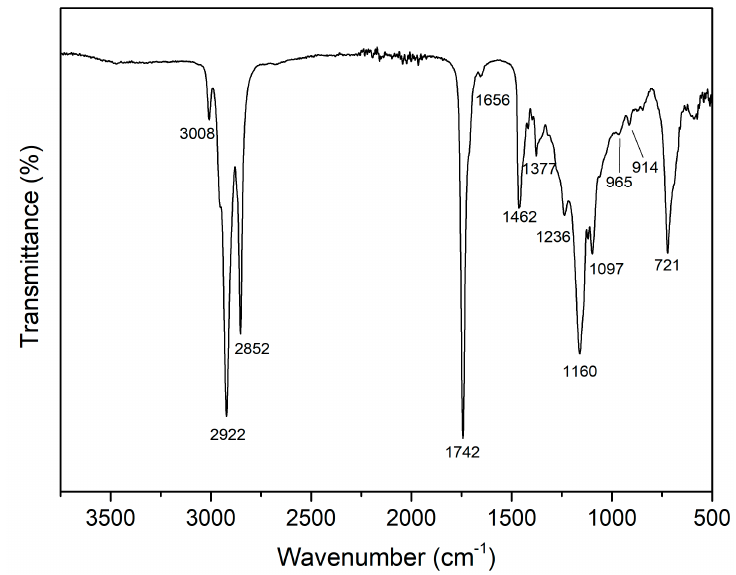
Figure 4. FTIR spectrum of TSO extract obtained under optimum MAE conditions.